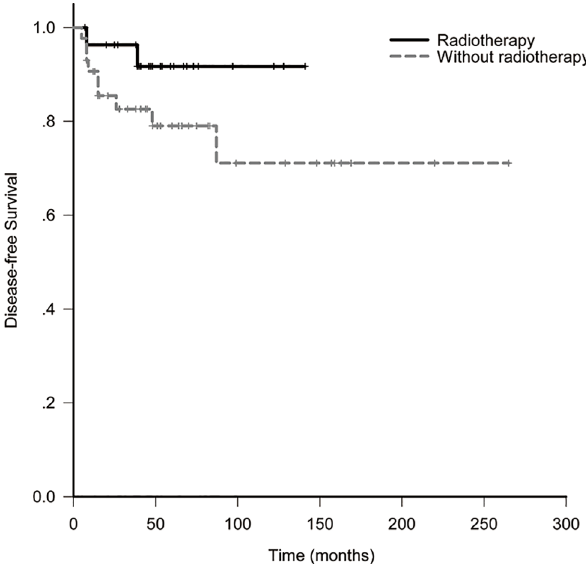
Fig 2. Disease-free survival of patients with or without radiotherapy.